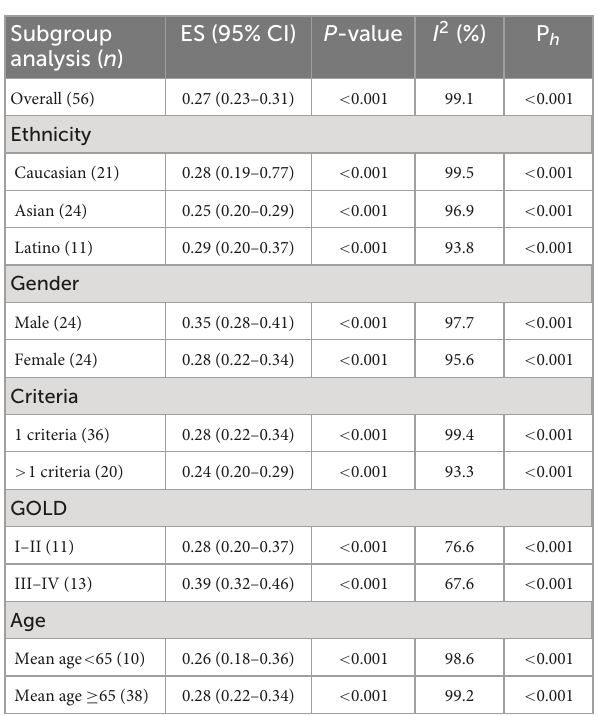
TABLE 2 Subgroup analyses on the incidence of sarcopenia in various conditions.